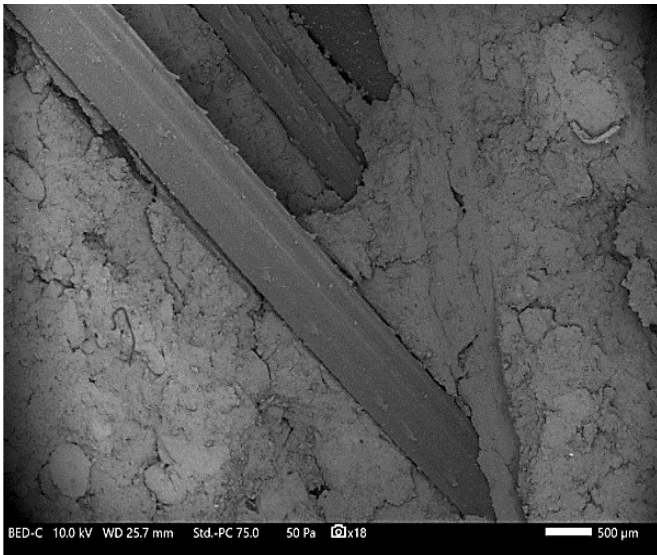
Figure 15. Inking of Diss fiber spines in soil matrix.